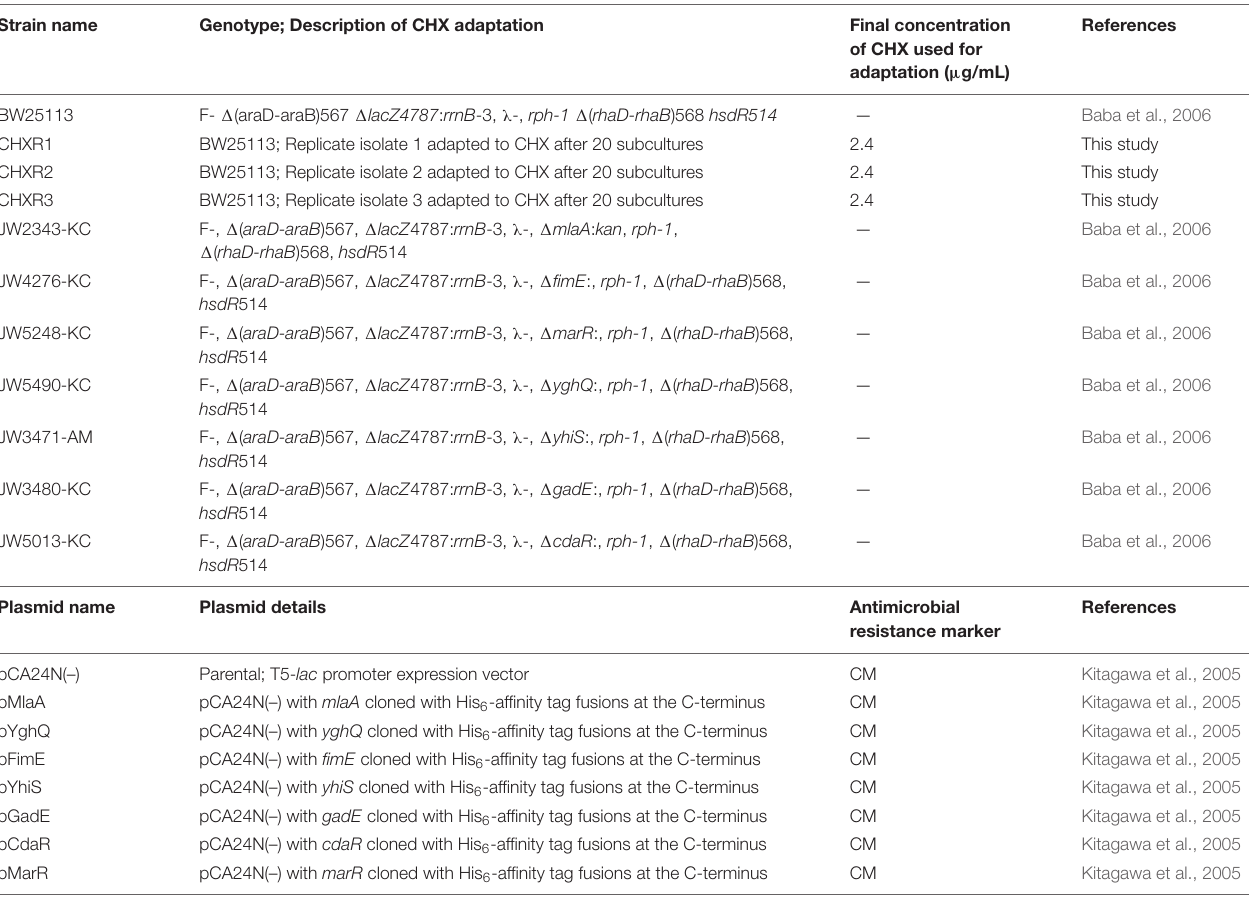
TABLE 1 | Bacterial E. coli strains and plasmids used or generated in this